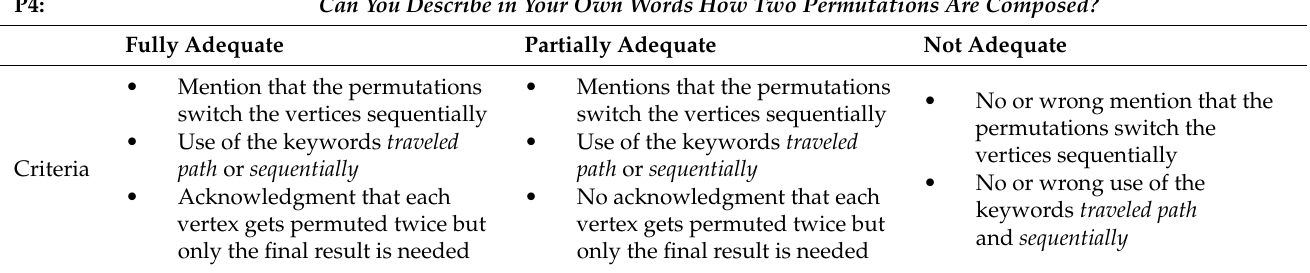
Table A12. Coding manual for the paraphrasing of key idea 4.